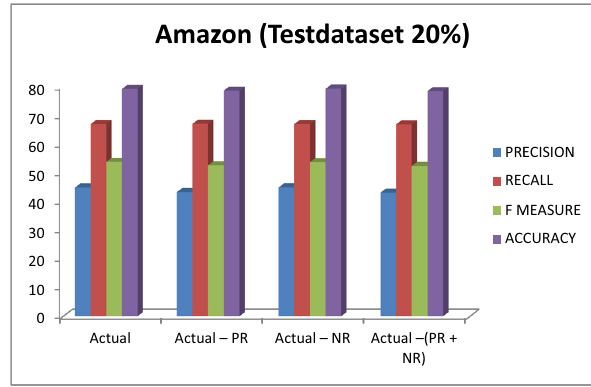
Figure 4: Plot for Amazon 20% test dataset.